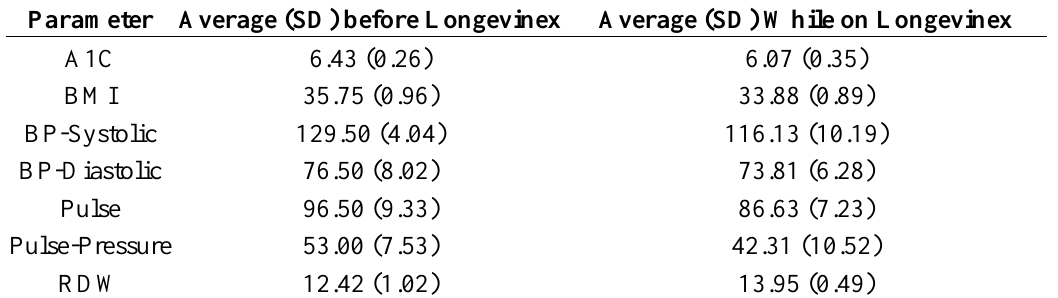
Table 1. Cardiovascular and serum parameters of a 64-year-old male patient with AMD and diabetes type 2. There are broad improvements over time in his HBA1c, BMI (body mass index), systolic, diastolic, pulse and pulse-pressure. Measurements were taken from his medical records months before starting L/RV and months following initiation of epigenetic therapy (see text for